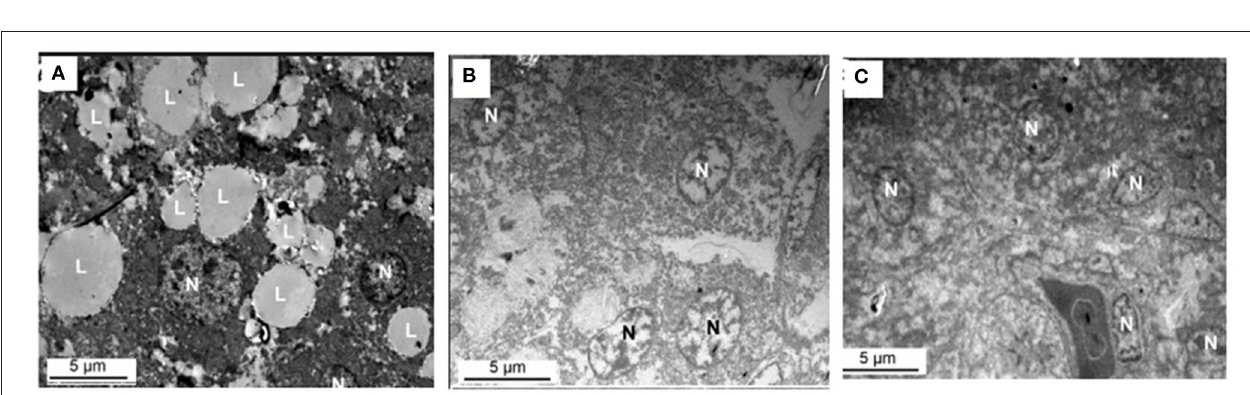
FIGURE 8 | Ultramicroscopy of livers from chicken fed with or without addition of folic acid. (A) C group, there are a lot of large lipid droplets in the liver cell. (B) M group, there are few lipid droplets in the liver cell. (C) H group, there are few lipid droplets in the liver cell. L, lipid droplet; N, nucleus.